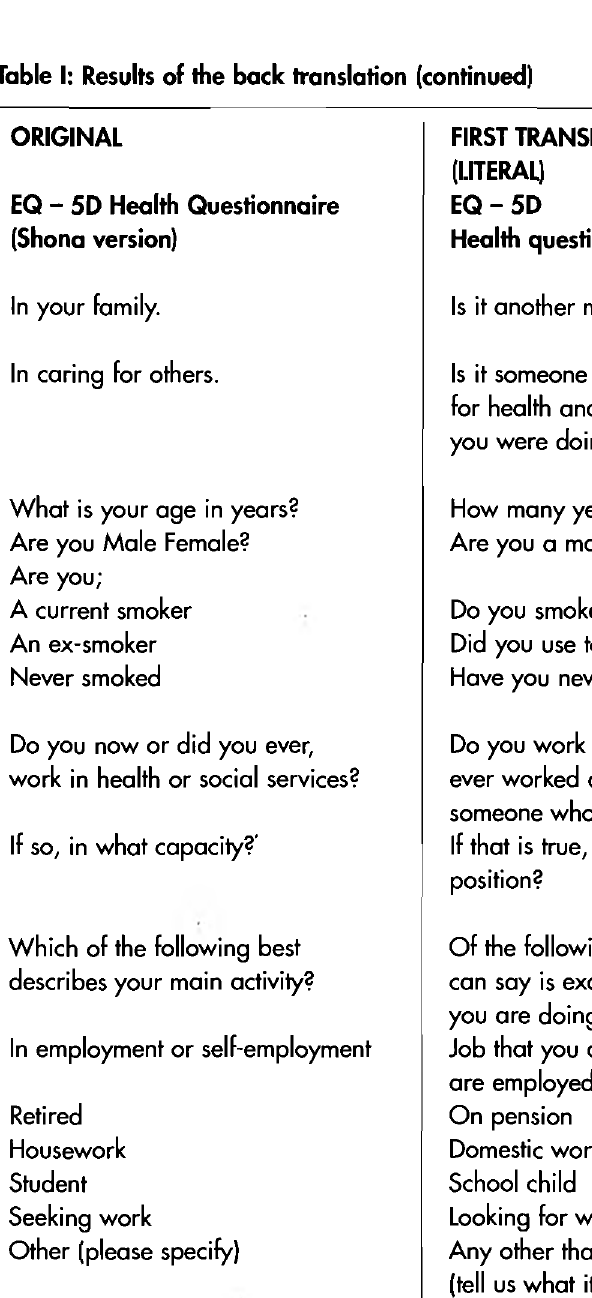
Table I: Results of the back translation (continued)